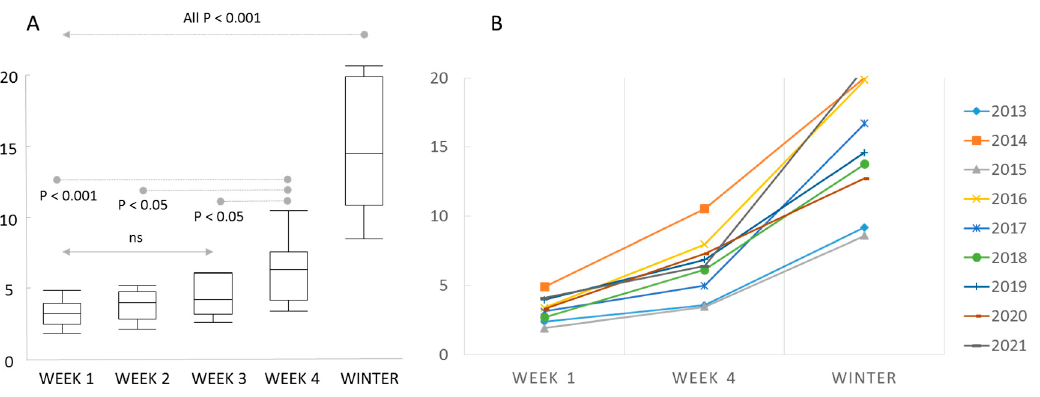
Figure 3. Colony loss rates relative to the standardised week of response to the late summer/autumn survey. The winter colony loss rates are shown for comparison. ( A ) Box plots of averages among years with significance estimates. ( B ) Annual loss rates in autumn in response week 1 and week 4 and winter loss rates. The loss rates increase between week 1 and week 4 each year.